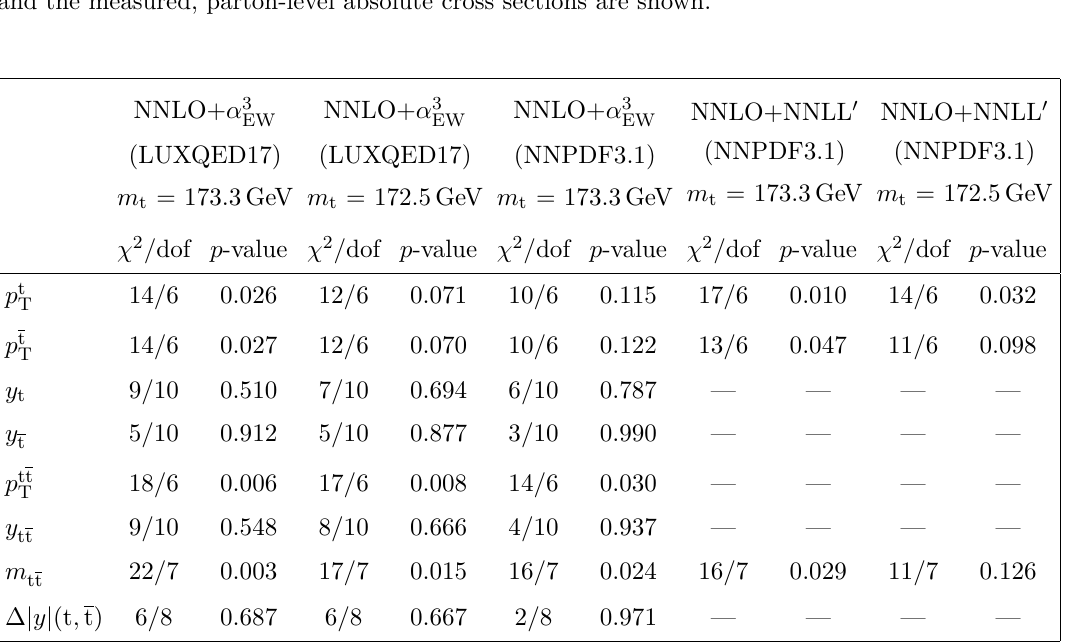
Table 51 . The (cid:31) 2 /dof and p -values quantifying the agreement between the three MC predictions and the measured, parton-level absolute cross sections are shown.